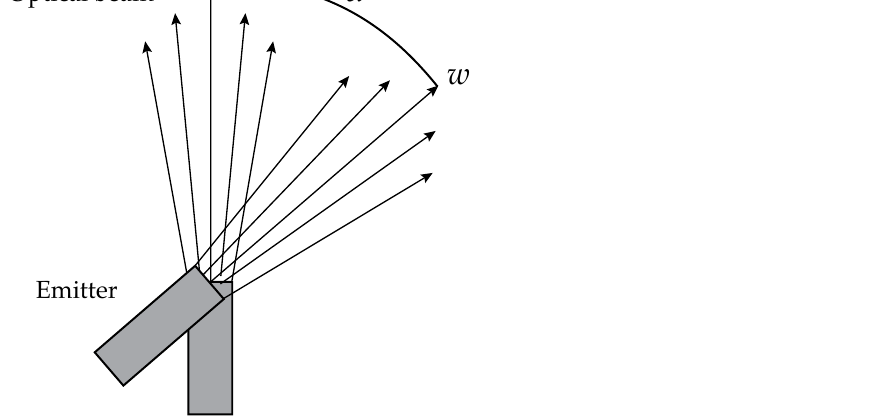
Figure 5. Rotation of the emitter direction from the default ˆ z direction to any desired vector w .